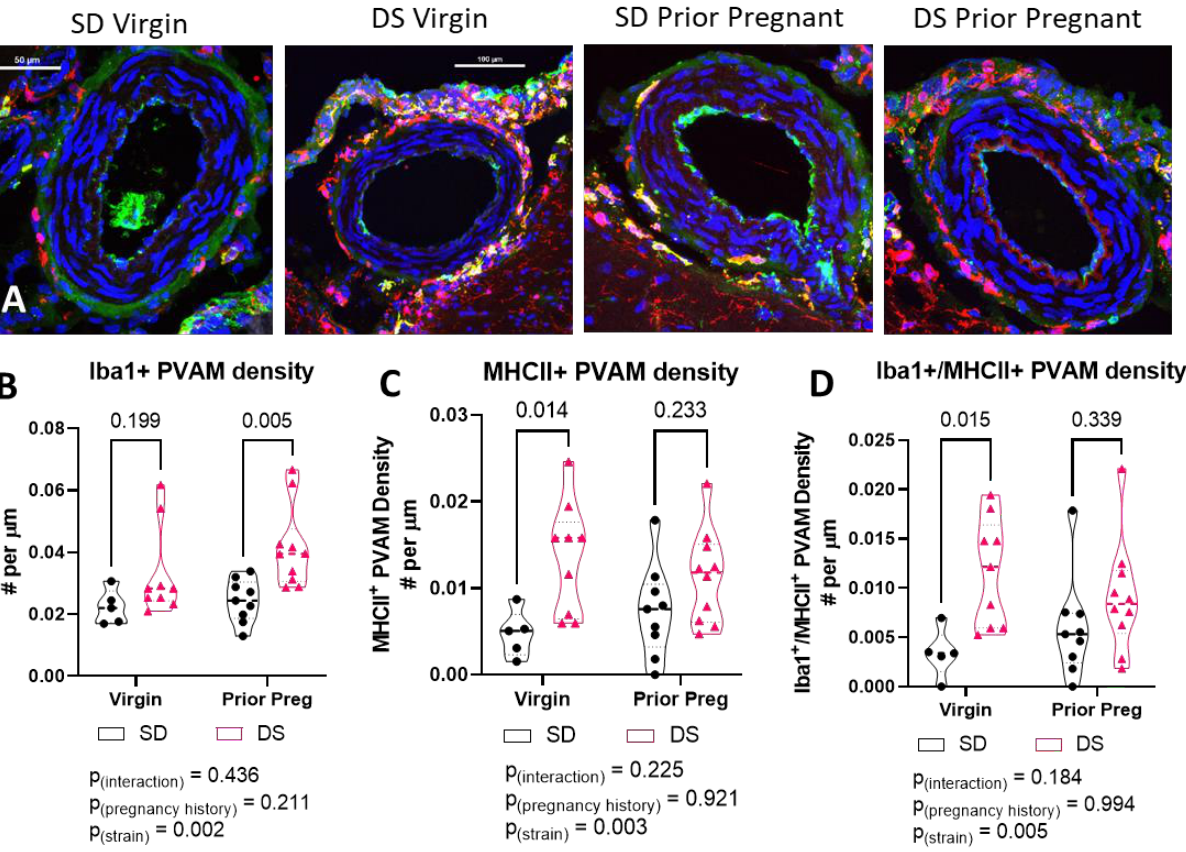
Figure 5. Representative images from each group showing Iba1 and MHC-II staining in PVAMs ( A ). Images were then analyzed. There was only a main effect of strain on density of PVAMs that were Iba1+ ( B ), MHCII+ ( C ) or Iba1+/MHCII+ ( D ). Red = Iba1, Green = MHC-II, Blue = DAPI. Scale bar = 100µm. SD — Sprague Dawley, DS — Dahl-SS/Jr.